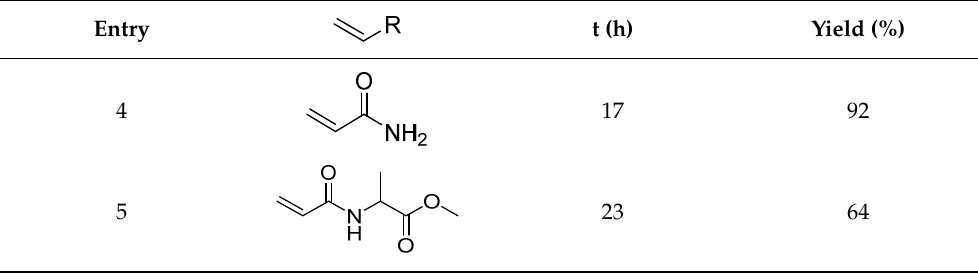
Table 12. Generalization of the method by Skrydstrup’s